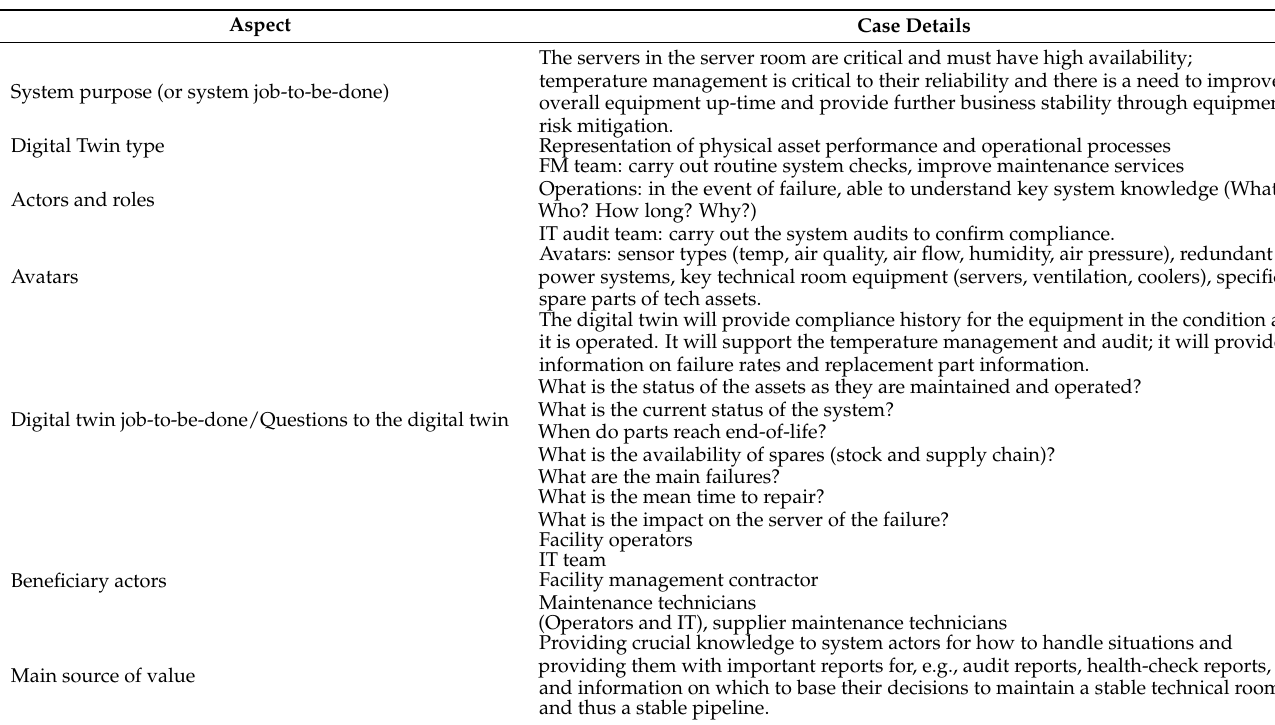
Table A9. Case 7—server room temperature